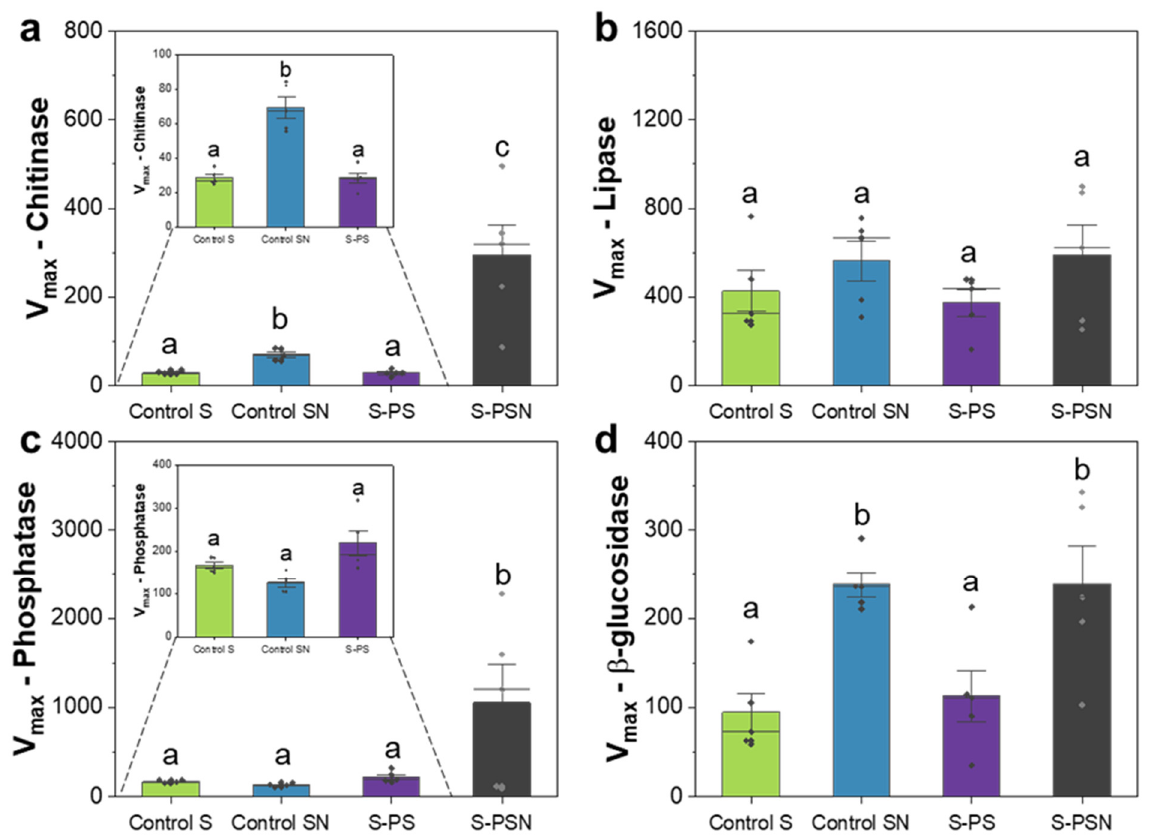
Figure 4. Mean of maximum rate of reaction (V max ) of chitinase ( a ), lipase ( b ), phosphatase ( c ), and β –glucosidase activity ( d ) of each treatment. Analysis of variance (ANOVA) or Kruskal–Wallis test was performed for the data with equality and non-equality of variance, respectively. Standard deviation of five replicate measurements are shown. The rhombs on the bars indicate the data points. Different letters indicate significant differences according to ANOVA ( p < 0.05). Details of the treatment abbreviations can be found in the legend of Figure 1.